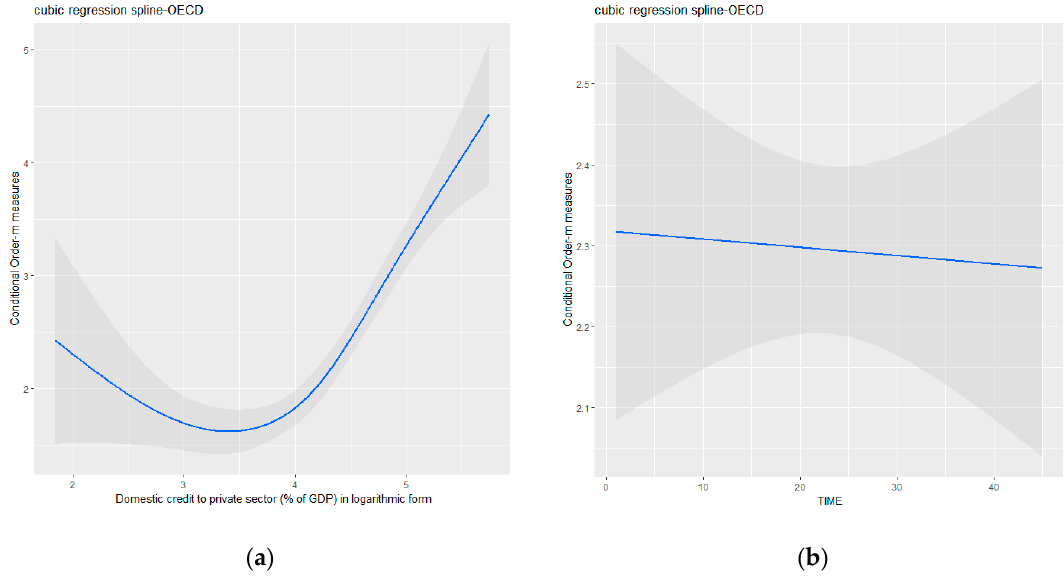
Figure 4. The effect of domestic credit and time on countries’ production efficiencies (OECD countries): ( a ) The effect of domestic credit to private sector (OECD countries); ( b ) the effect of time (OECD countries).